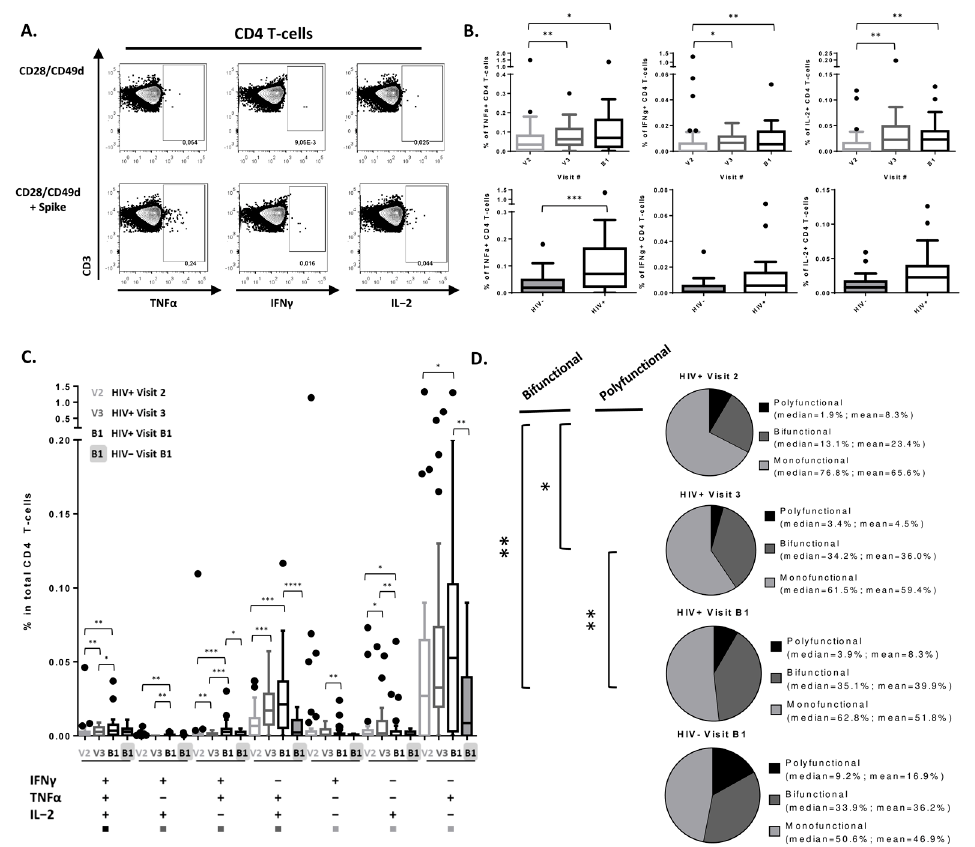
Figure 2. SARS-CoV-2-specific CD4 T-cell response. ( A ) Examples of flow cytometry plots of live CD4 T-cells with gates on TNF α +, IFN γ +, and IL-2+ cells from left to right, respectively. Signal detected in “CD28/CD49d” was subtracted from “CD28/CD49d + Spike” for all samples. ( B ) Frequencies of TNF α +, IFN γ +, and IL-2+ CD4 T-cells post 1st, 2nd, and 3d vaccine doses in PLWH (top row) and post 3d vaccine dose in PLWH versus seronegative controls with (bottom row). Lines in HIV+ versus HIV- plots indicated the median and interquartile range. ( C ) Frequencies of cytokine producing SARS-CoV-2-specific CD4 T-cells in total CD4 T-cell pool at different time points in PLWH and uninfected controls. Squares at the bottom of the graph indicate whether the cell subset was classified as polyfunctional, bifunctional, or monofunctional when graphing the pie chart on Figure 2D. ( D ) Proportions of polyfunctional, bifunctional, and monofunctional cells within SARS-CoV-2-specific CD4 T-cells at different time points in PLWH and uninfected controls. Median frequencies of each subset in SARS-CoV-2-specific CD4 T-cells are indicated to the right of each pie chart. Pie charts were generated using the mean values. Comparisons were made using Wilcoxon-Pratt signed rank test for paired variables and Mann–Whitney for unpaired variables (* p < 0.05, ** p < 0.01, *** p < 0.001, **** p < 0.0001). Study visits: V1—pre-vaccination baseline, V2—1 month post 1st dose, V3—3 months post 2nd dose, B1—1 month post 3rd